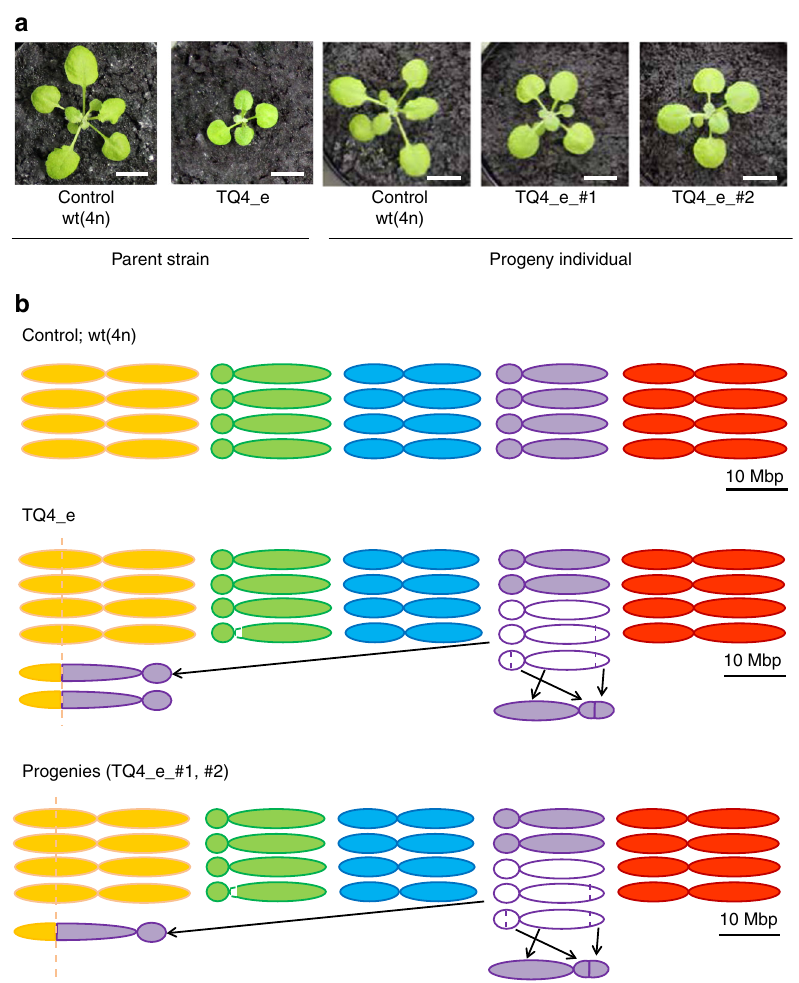
Fig. 5 Changes in leaf size and estimated chromosome structure in TQ4_e and progenies plants. a Images and b estimated genome structure of TQ4_e (TAQed mutant), progenies (TQ4_e_#1 and #2) and control plants grown in soil for 3 weeks. Scale, 10